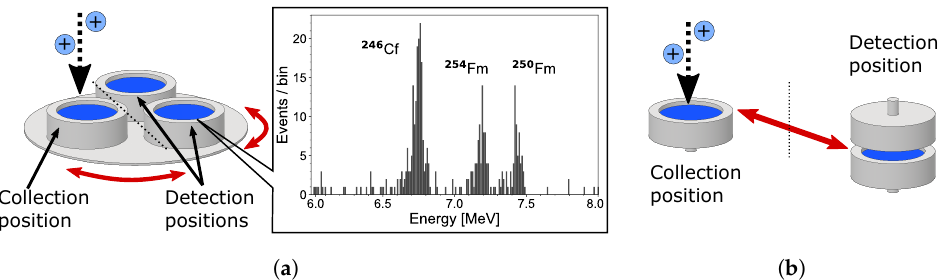
Figure 2. ( a ) Schematic drawing of the rotatable RADRIS detector setup. Laser ions (blue) are guided towards the PIPS detector in on-axis position in the collection mode. For the next collection, the detectors are rotated such that the next detector is placed on-axis with the chamber. Subsequent decays on the prior collection detector are registered in an off-axis detection position. An alpha spectrum on one of the detectors is shown for accumulated 254 Fm RIS signals of a measurement time of approximately 5days. ( b ) Schematic drawing of the movable double-detector setup. Laser ions (blue) are guided towards the on-axis PIPS detector in the collection mode. For the detection mode, the detector is moved on top of a second PIPS detector to detect alphas emitted in the hemisphere opposite the active area of the collection